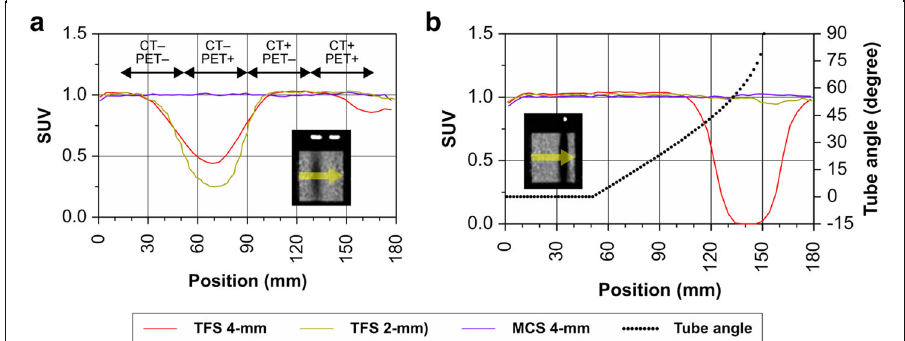
Fig. 8 Average SUV per slice of phantom images for the urine shift pattern ( a ) and the tube curve pattern ( b ). The origin ( x -axis) of the slice position corresponds to the left limit of the phantom in sagittal